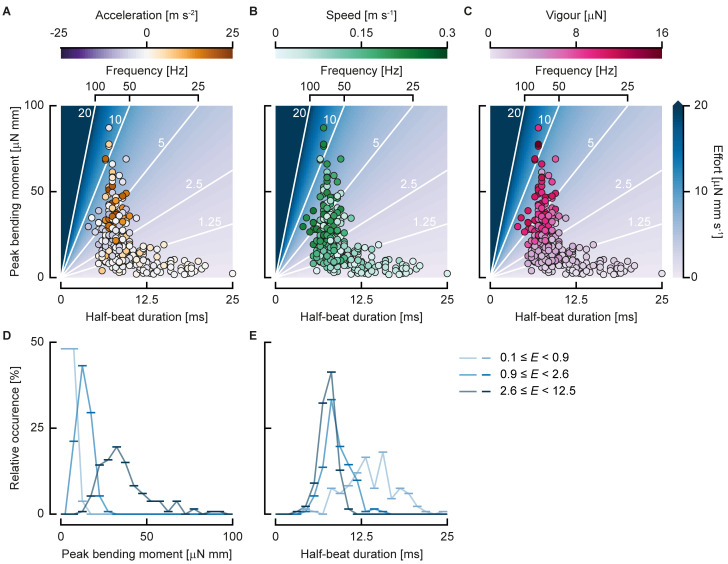
Swimming control parameters.(A, B, C) Individual half beats in the duration–peak bending moment landscape. The coloured background with white contour lines shows the swimming effort (N = 285). (A) Dot colour indicates acceleration. (B) Dot colour indicates speed. (C) Dot colour indicates swimming vigour. (D, E) Relative occurrence of half beats in bins (line markers) of peak bending moment (D) and half-beat duration (E) divided in 3 bins of swimming effort (colours), each containing the same number of half beats. Underlying data for panels A–E can be found in S1 Data.